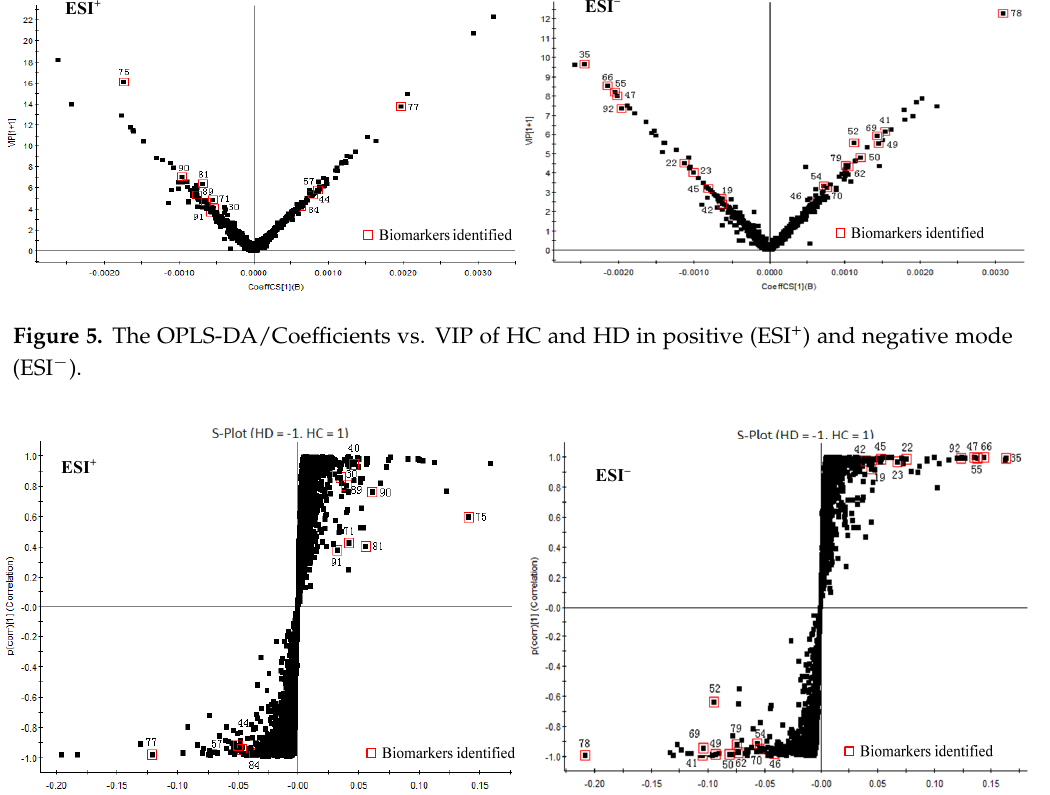
Figure 6. The OPLS ‐ DA/S ‐ Plot of HC and HD in positive mode (ESI + ) and negative mode (ESI − ).